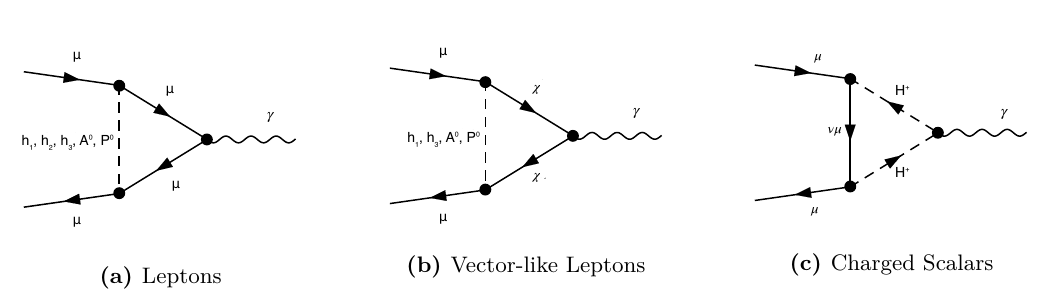
(b) Vector-like Leptons